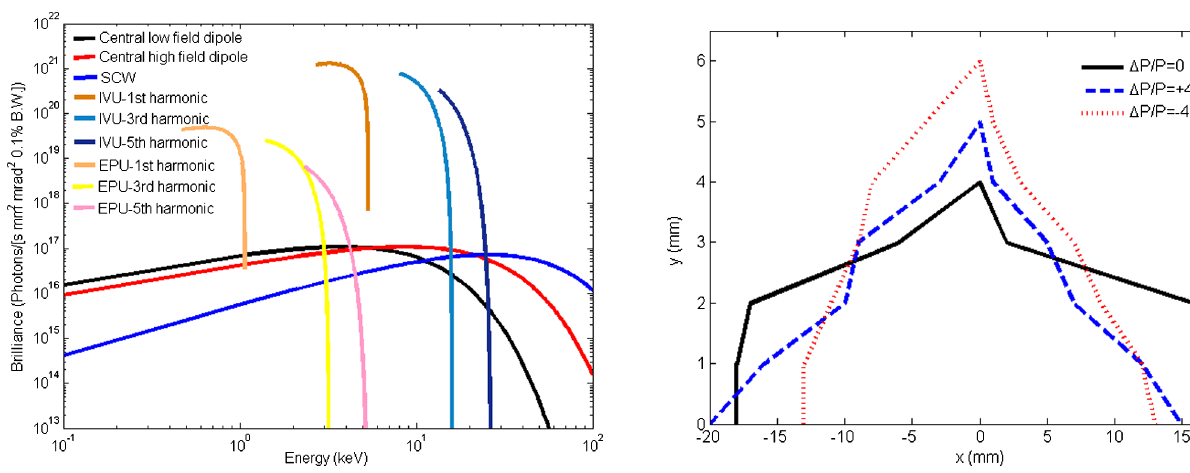
FIG. 17. The dynamic aperture in the presence of phase 1 IDs. The multipole errors have been included in the particle